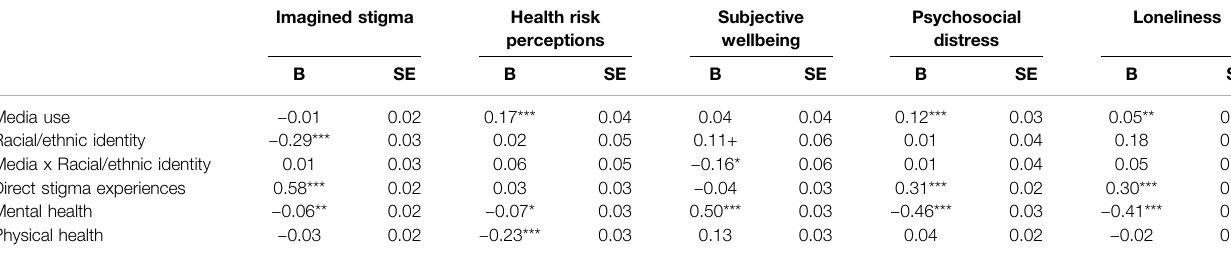
TABLE 3 | General linear models results testing H1 – H6 controlling for direct stigma experiences, mental health, and physical health.